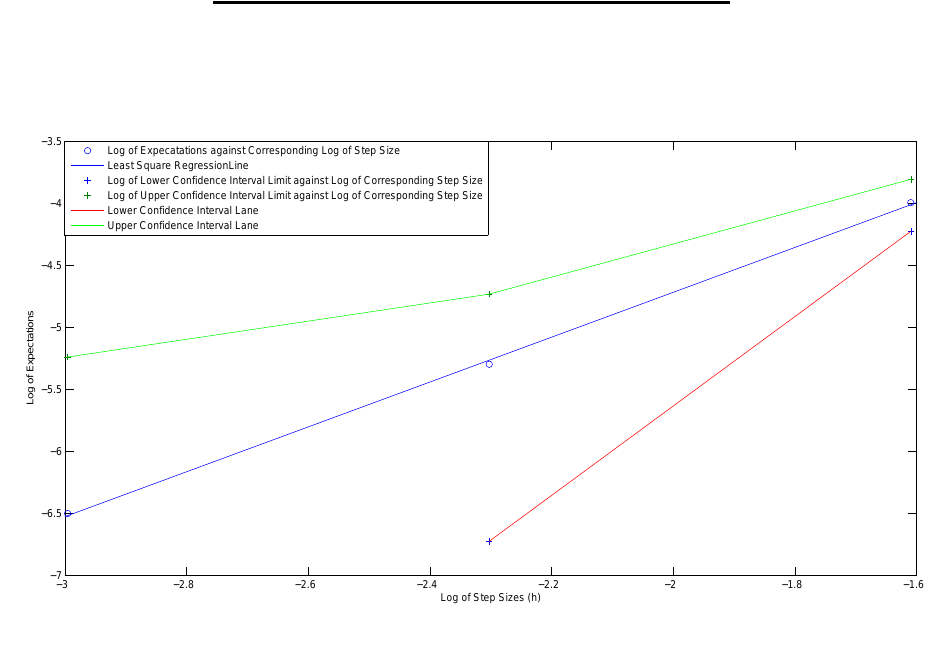
Figure 2: Convergence of the